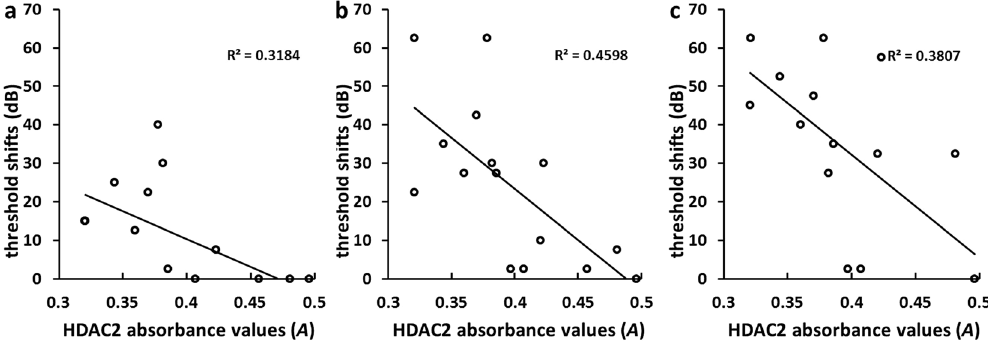
Figure 6. Correlation between ABR threshold shifts at different frequencies and HDAC2 levels in the cochlea. Negative correlation was observed at 8 kHz (( a ), correlation coefficient r value = − 0.56, p < 0.05), 16 kHz (( b ), r value = − 0.68, p < 0.05) and 32 kHz (( c ), r value = − 0.62, p <